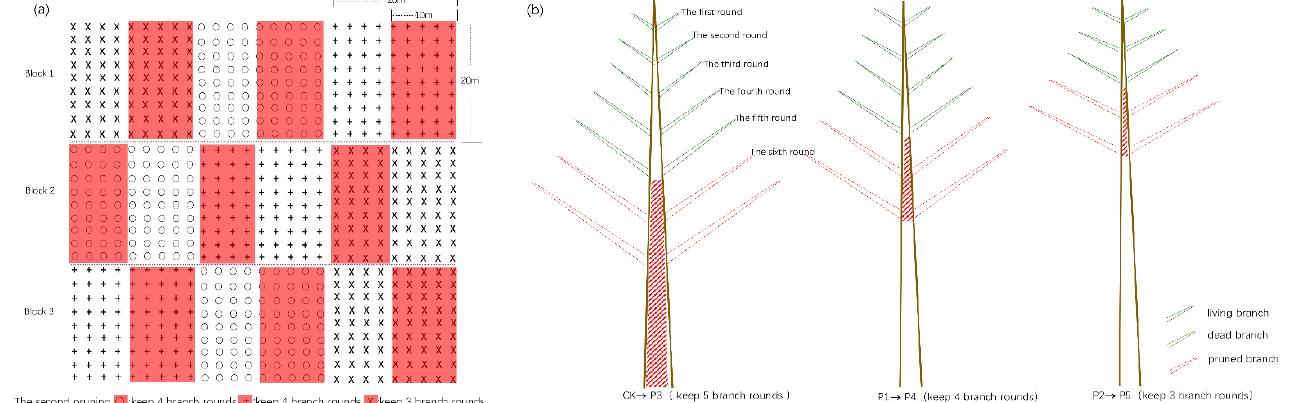
Figure 2. The arrangement of sample plots ( a ) and the pruning diagram ( b ) of the second pruning intervention. Di ff erent symbols with red marks in the arrangement diagram represent the three dif- ferent treatments that were carried out in the second pruning.